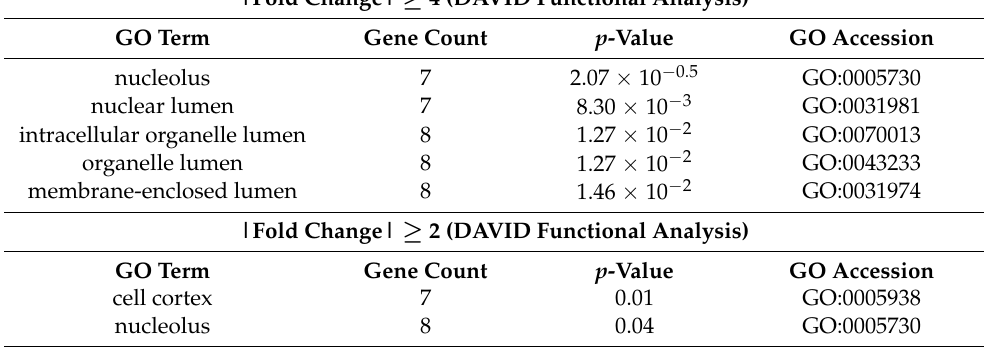
Table 2. Cellular component groups identified by the functional annotation clustering analysis with |fold change| ≥ 4 and 2 (DAVID functional analysis).